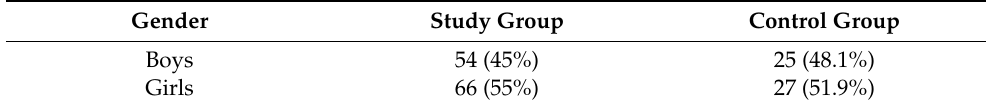
Table 1. Division of all eligible children according to group and